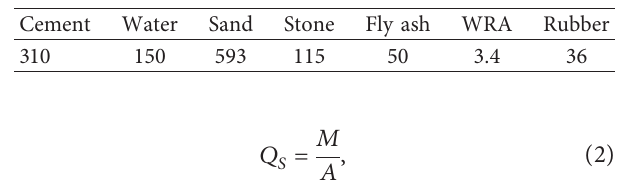
Table 2: Mix proportions of CRC (kg · m − 3